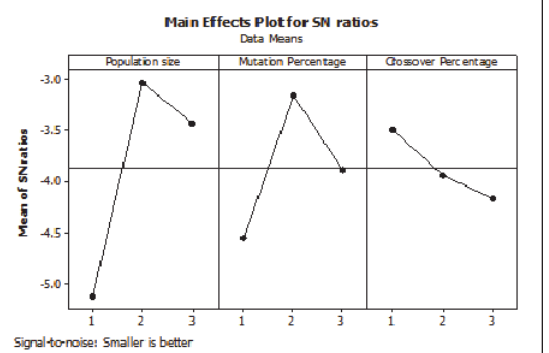
Fig. 1 . Mean S/N ratios for the proposed GA